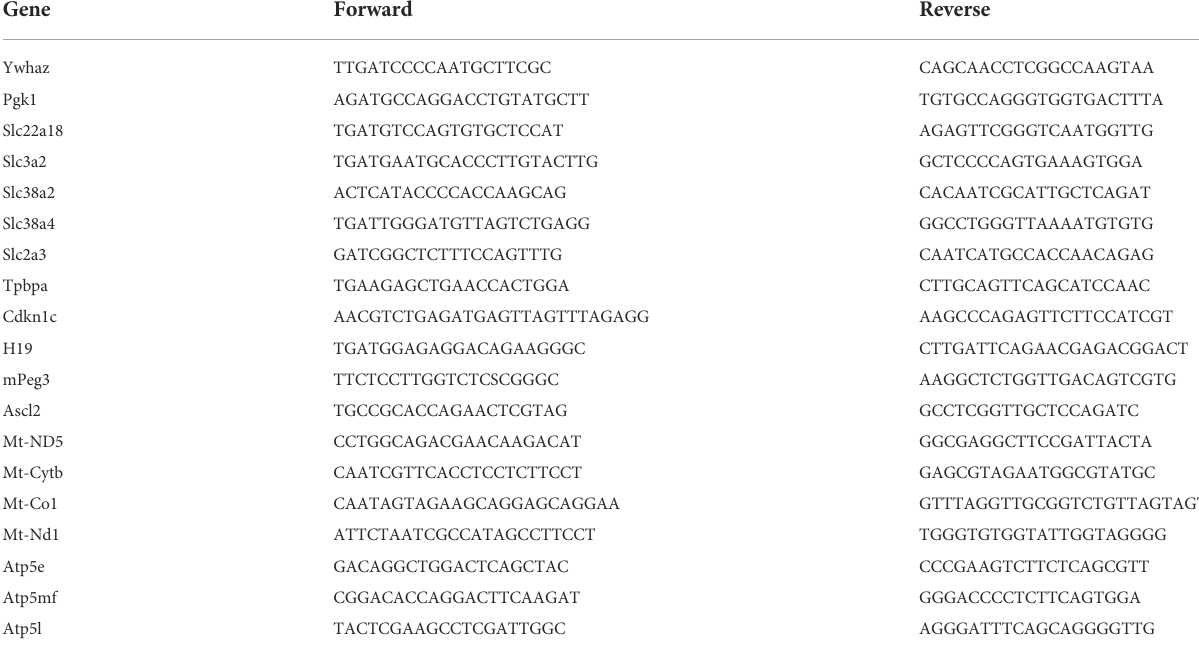
TABLE 1 RT-qPCR